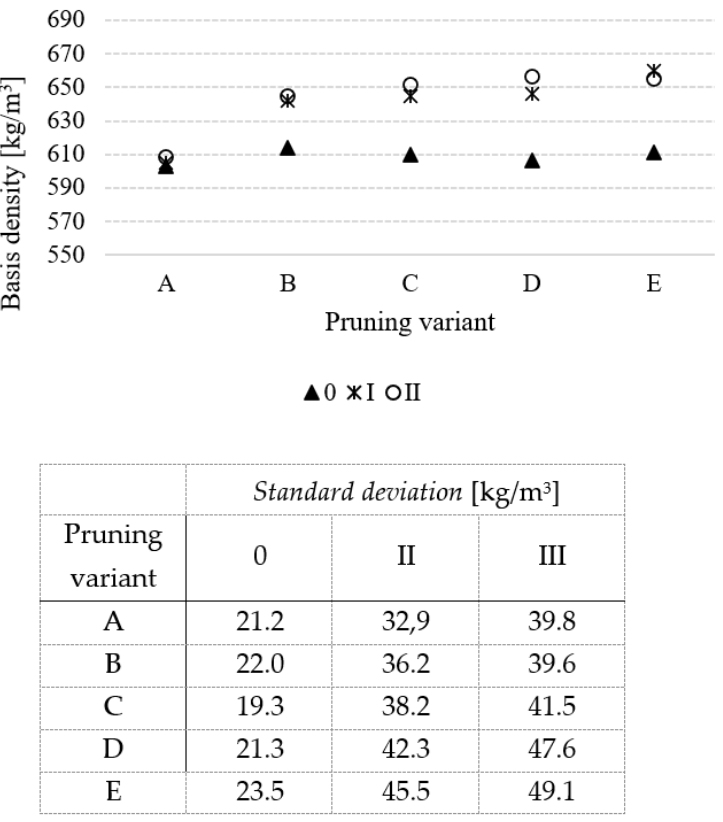
Figure 7. Mean wood density of pine depending on the pruning variant and the amount of time since the procedure (0 = up to 15 years, I = 16–25 years, II = 26–35 years).